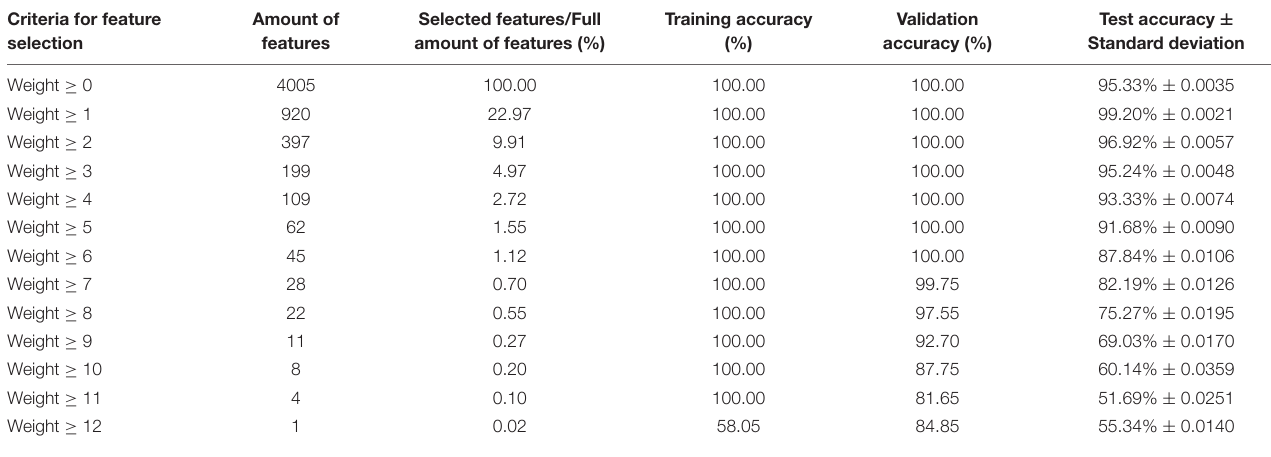
Amount of Selected features/Full features amount of features (%)